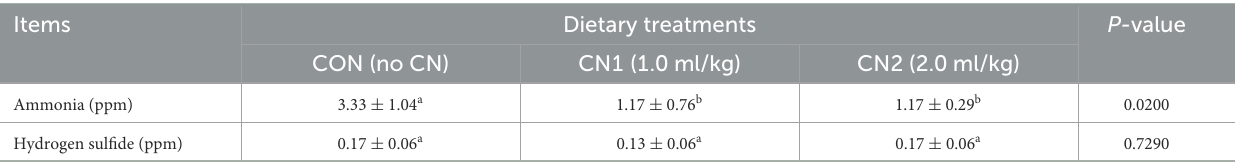
TABLE 7 Dietary curcumin nanospheres (CN) on ammonia (NH 3 ) and hydrogen sulfide (H 2 S) gas contents in the feces of finishing pigs for 40 days 1 .